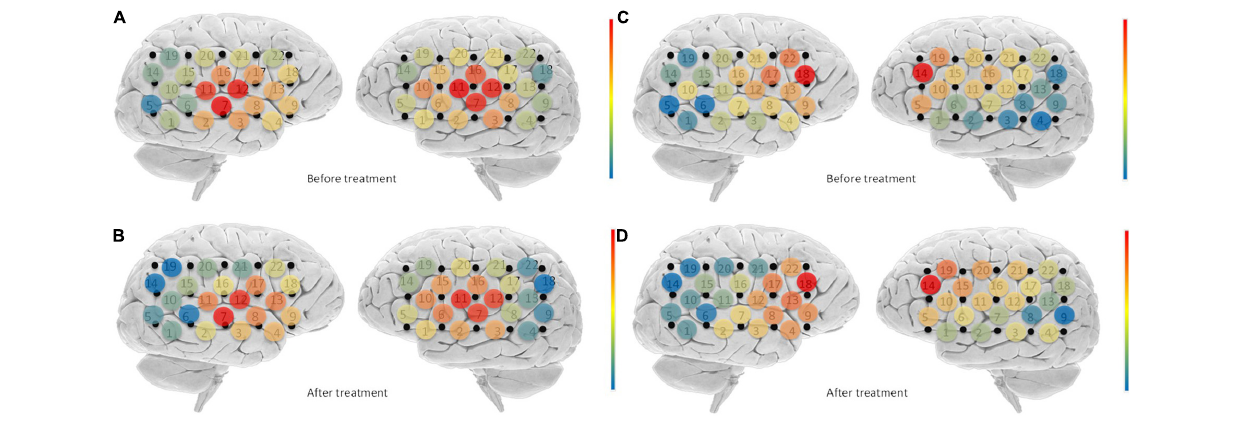
FIGURE 4 | Changes in connectivity before and after treatment. Blue indicates low channel connectivity to the ROI in this area, and red indicates higher connectivity. Comparison of STC before and after treatment (A,B) , found that the connectivity of right channel 14 was significantly reduced after treatment. For BA46 (C,D) , the connectivity of channels 10, 14, 16, 20, 21, and 22 on the right side was significantly reduced after